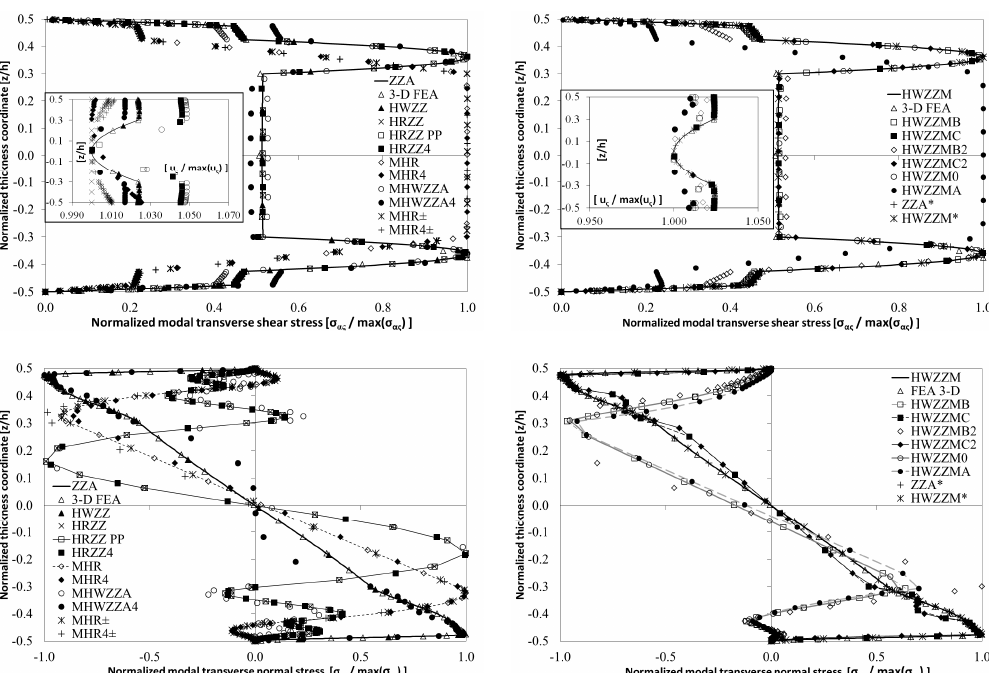
Figure 9. Case g: Normalized modal displacements and stresses of a simply supported sandwich plate in cylindrical bending ( L x/ h = 5, first mode).